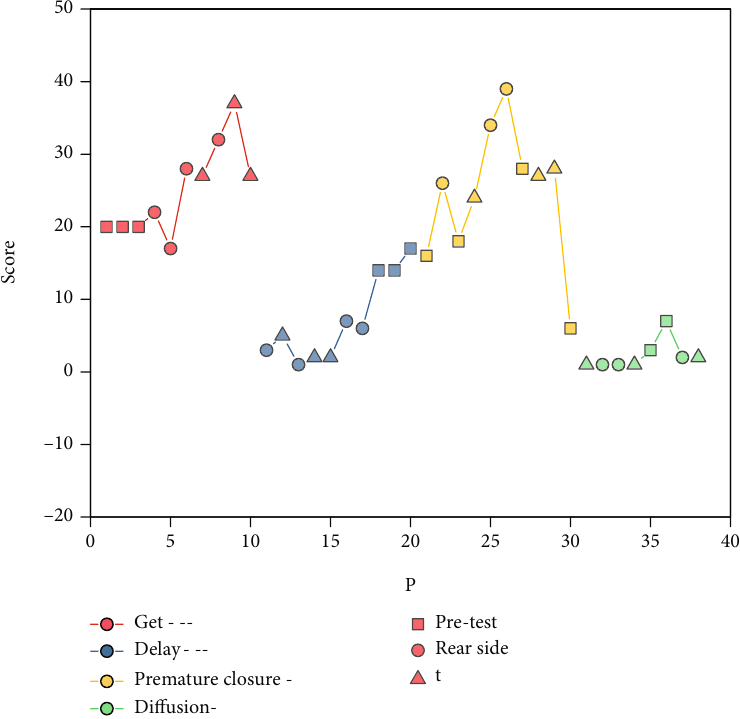
Figure 6: Paired sample test for each dimension of